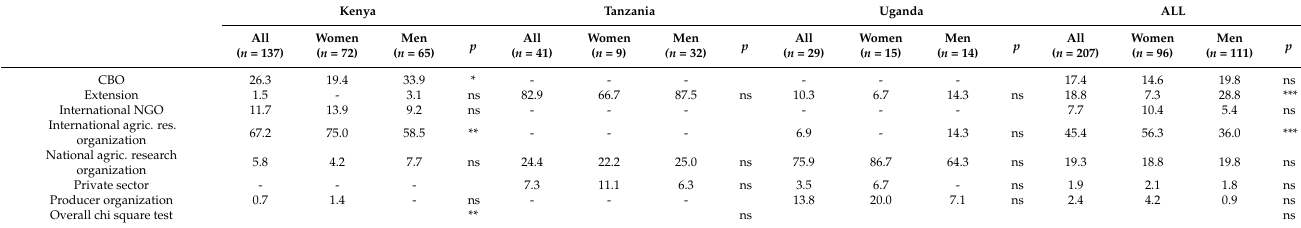
Table A5. Affiliations of the experts with whom farmers discuss seed information (% of respondents). Kenya Tanzania